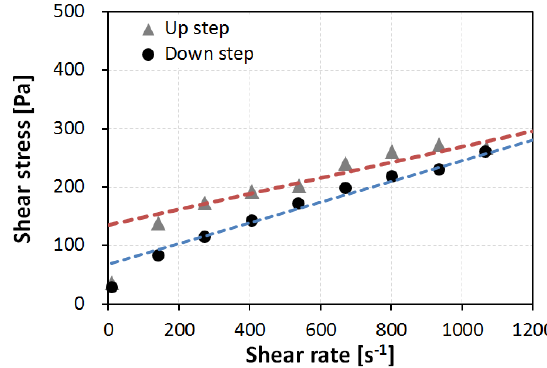
Figure 4. Obtained flow curves of the sample WB35 ‐ PCE0.2 according to the up step and down step of Measurement 1.